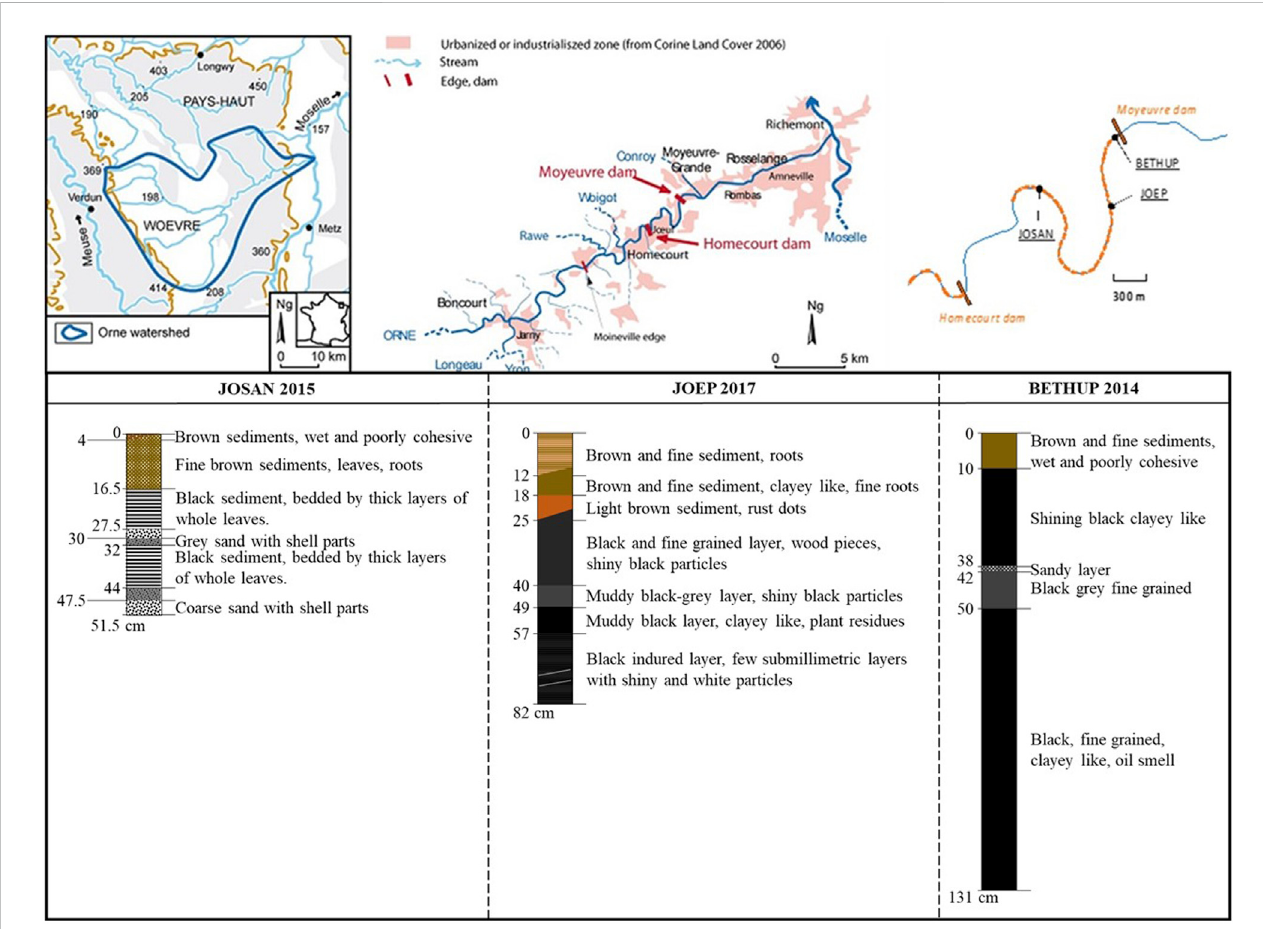
FIGURE 1 TheOrneRiverbasin,thedownstreamareawheresteel-makingfacilitiesanddamswereinstalledandafocusonthein fl uencezone(orangedashedline) of the Moyeuvre dam, also called Beth dam with the location and the log description of the three riverbank cores selected in this study (from upstream to downstream: JOSAN, JOEP and